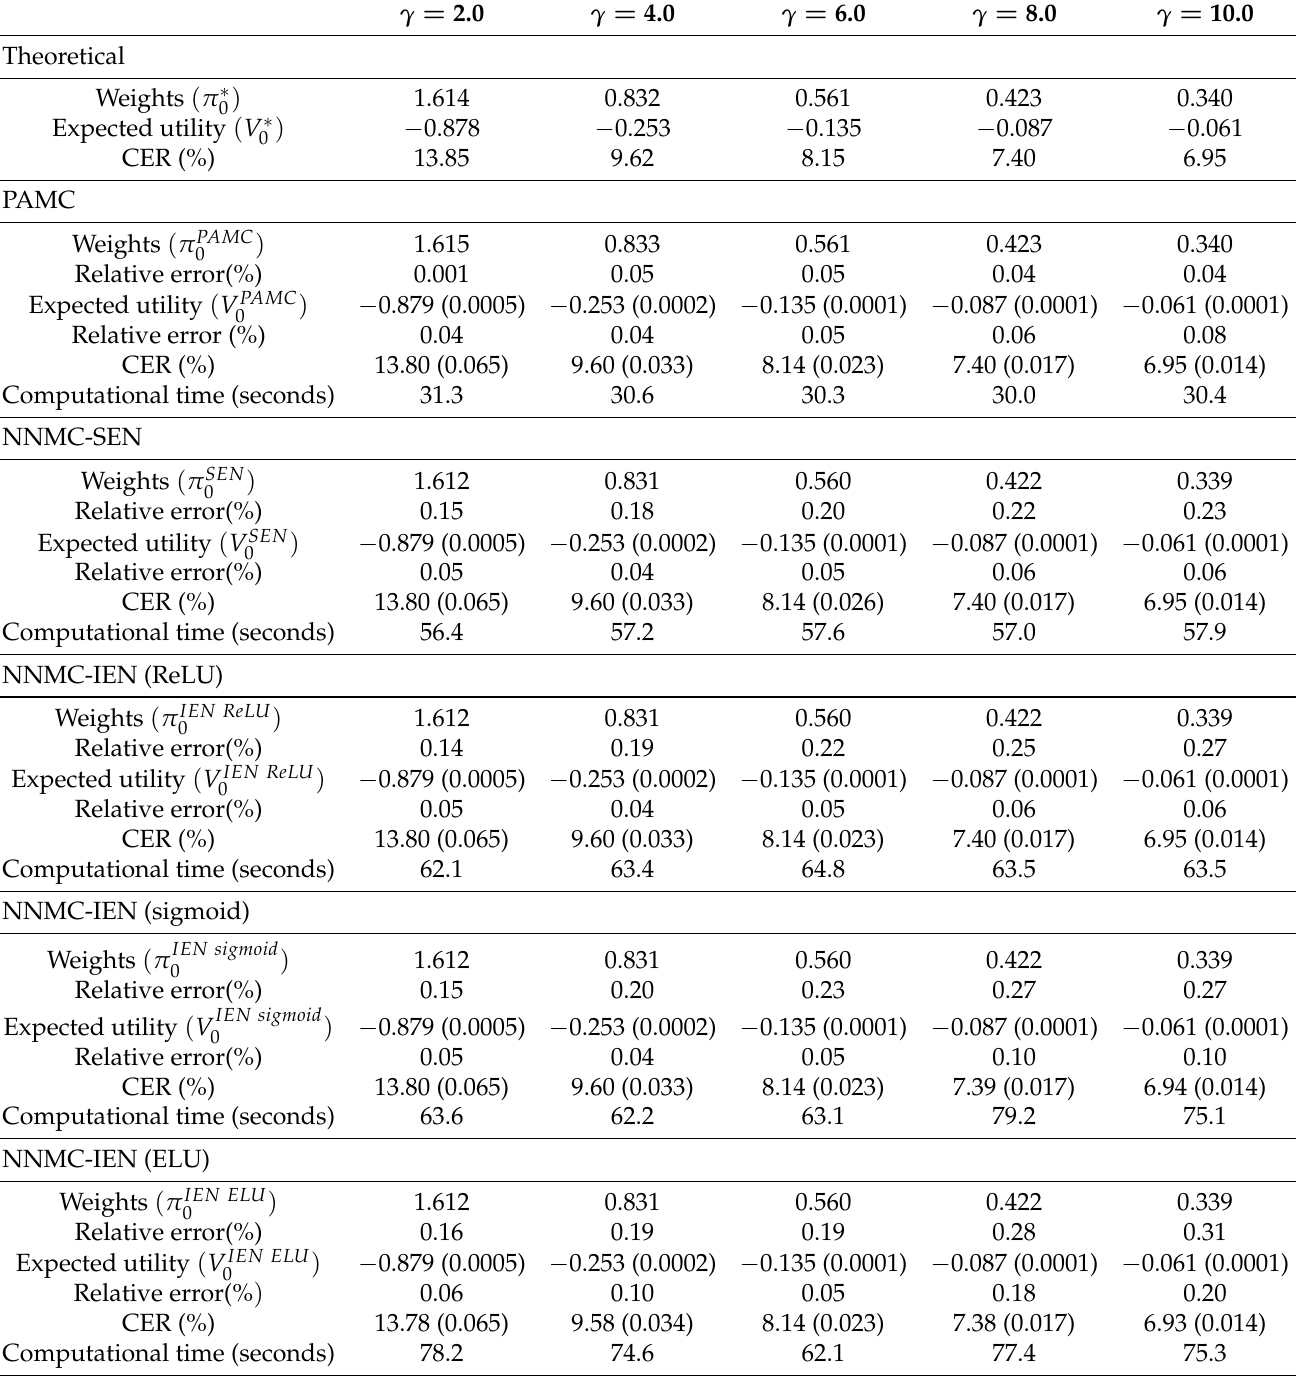
optimal allocation and computation efficiency. Moreover, the ReLU activation function is superior to the sigmoid and ELU function when the IEN is applied. √ X t . We reported the optimal weights, expected utility Table 3. Results for the 4/2 model with a market price of risk λ S and CER obtained with the theoretical result and with the approximation method for different levels of risk aversion γ . The standard deviation of estimated expected utility and CER from 100 runs is displayed in